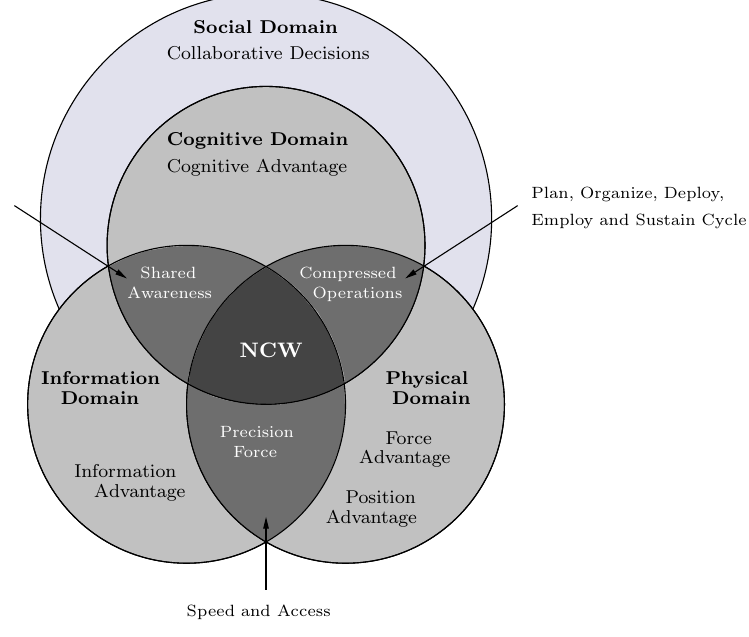
Figure 7: The four domains of NCW